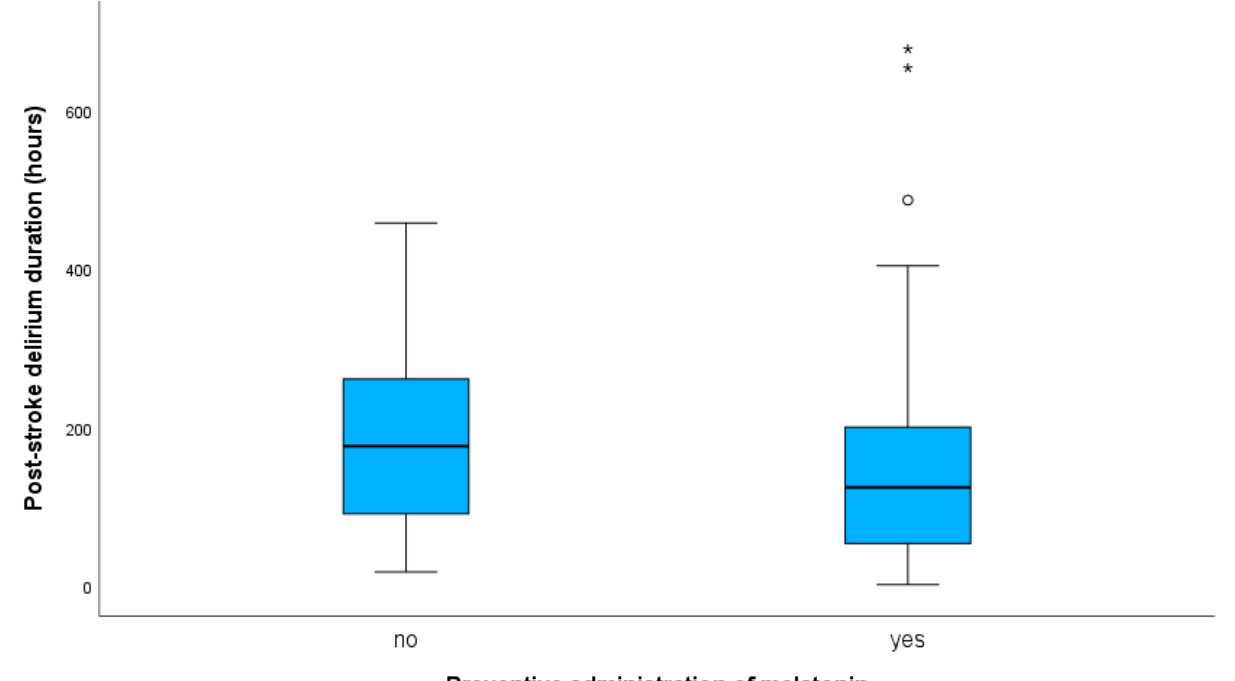
Figure 1. Box plots presenting data for post-stroke delirium duration (hours) in post-intracerebral hemorrhage patients with respect to administration (or not) of melatonin. In the box plot, the black line within a box indicates the median, the boundary of the box closest to zero indicates the 1st quartile, and the boundary of the box farthest from zero indicates the 3rd quartile. Outliers with values more than 3 interquartile ranges (IQRs) from the end of the box are denoted with an asterisk (*). Outliers with values more than 1.5 IQRs, but less than 3 IQRs from the end of the box, are denoted with a circle (o). Whiskers above and below the box indicate max and min values, respectively, not including outliers. Median duration of delirium in patients receiving melatonin was 124 h, and 176 h in the control group. Table 4. Effect of melatonin administration on PSD duration.